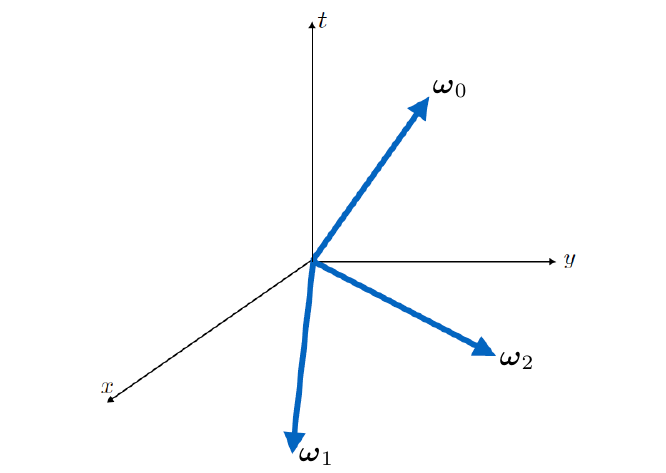
Figure 3 . Vector moduli of T 3 torus in (2 + 1)